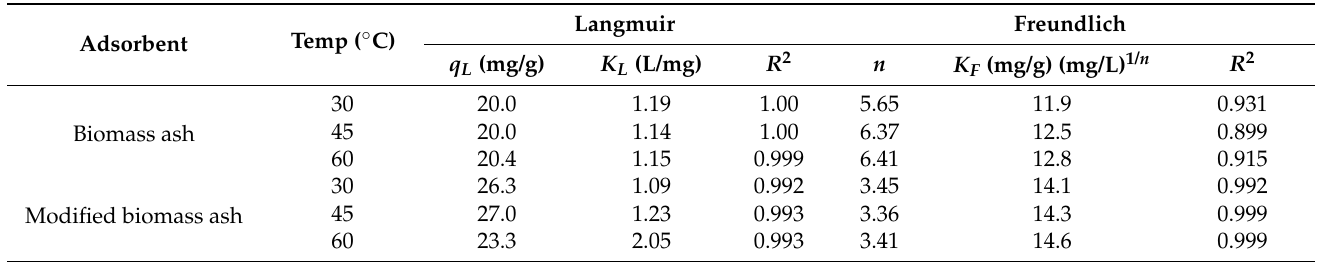
Table 2. Values of the constants and fitting of the adjusted adsorption models.